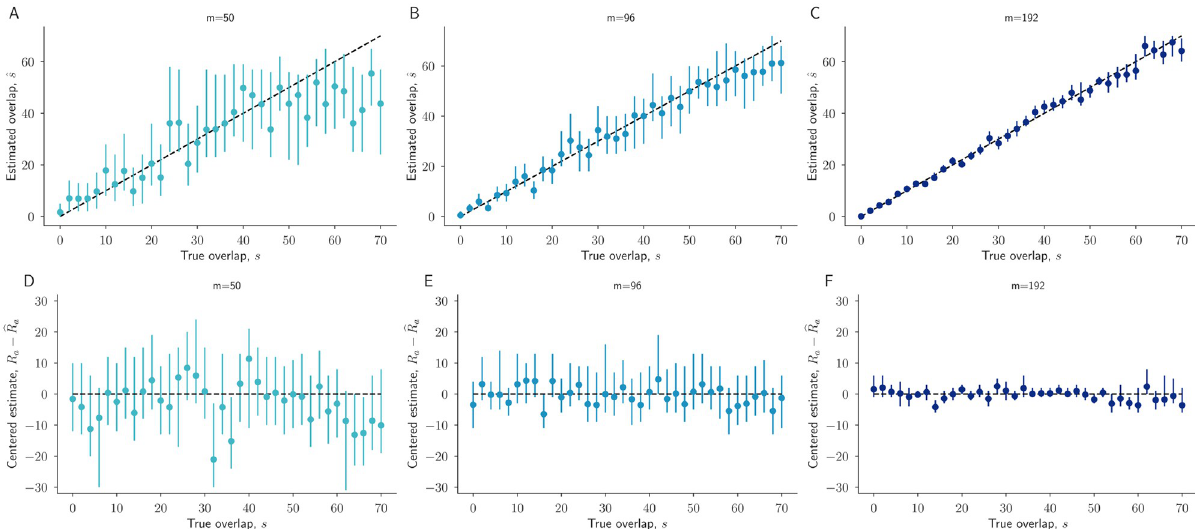
Fig 4. Credible intervals quantify uncertainty in overlap estimates. For each overlap value s between 0 and 70, we performed one simulation to generate synthetic count data (Methods). Estimates from the resulting count data, using our statistical model, of s (A,B,C), and error in R a and R b (D,E, F) are shown. Estimates (dots) and 95% credible intervals (lines) are shown for sampling efforts m = 50, 96, 192 in left, middle, and right columns,